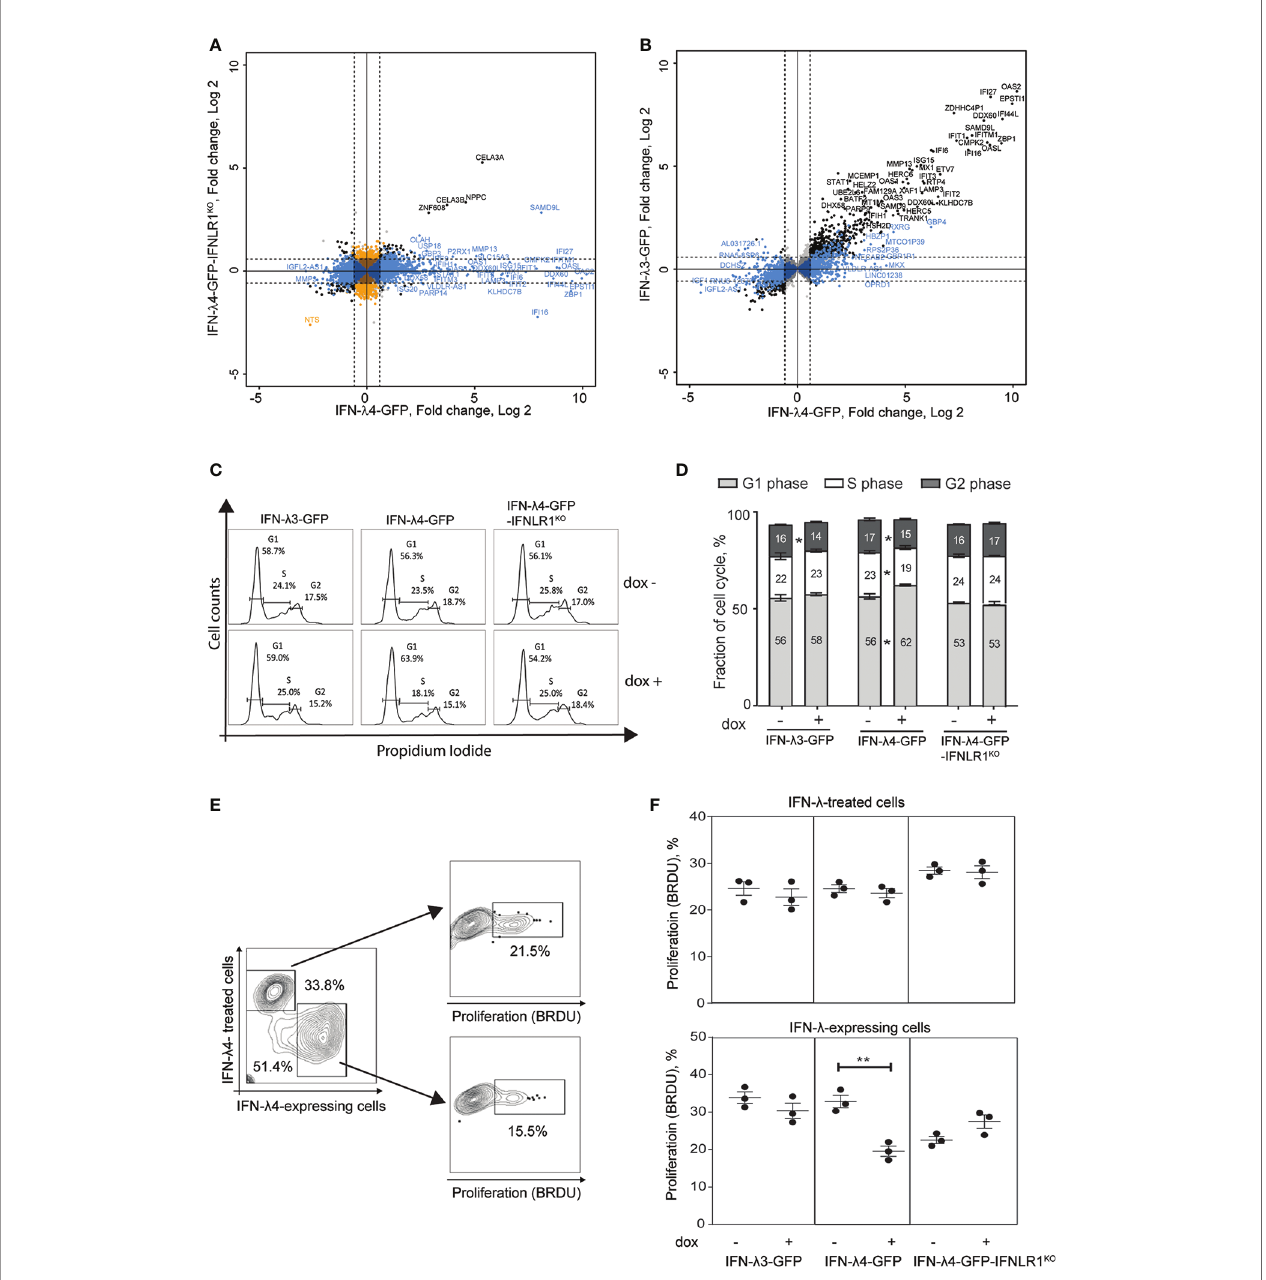
FIGURE 1 | IFN- l 4 inhibits the proliferation of HepG2 cells. RNA-sequencing analysis was used to identify differentially expressed genes (DEGs, P-FDR < 0.05) in IFN- l 3-GFP, IFN- l 4-GFP and IFN- l 4-GFP-IFNLR1 KO HepG2 cells after 72 hrs of induction by dox, compared to controls (dox- conditions). The cutoff threshold (fold change > +/-1.5) is indicated by dotted lines. (A) Analysis of all DEGs (n = 3251) detected for IFN- l 4-GFP or IFN- l 4-GFP-IFNLR1 KO cells. In blue - DEGs (n = 2,735) speci fi c to IFN- l 4-GFP and considered IFNLR1-dependent. In black - DEGs (n = 145) shared between both groups and considered IFNLR1-independent. In orange - DEGs (n = 371) speci fi c to IFN- l 4-GFP-IFNLR1 KO . (B) DEGs of IFN- l 4-GFP analyzed in IFN- l 3-GFP transcriptome. In black - DEGs (n = 1,506) shared in IFN- l 4- GFP and IFN- l 3-GFP and in blue - IFN- l 4-signature DEGs (n = 1,229) detected in IFN- l 4-GFP but not in IFN- l 3-GFP producing cells. Additional details are provided in Figure S2 and Table S1 . (C, D) Cell cycle analysis of cells synchronized by 24 hrs of serum starvation, treated with or without dox (0.5 µg/ml) for 72 hrs, and analyzed by fl ow cytometry after PI staining. The plot shows a representative picture and the percentage of cells in each phase of the cell cycle. All data are shown as mean± SEM from triplicate experiments. *P < 0.05, Student ’ s T-test comparing no dox to dox+ for each cell cycle stage. (E, F) Bromodeoxyuridine (BrdU, %) incorporation indicating cell proliferation in HepG2 cells expressing IFN- l 3-GFP, IFN- l 4-GFP and IFN- l 4-GFP-IFNLR1KO. Cells were cocultured with HepG2 cells labeled with Far Red proliferation dye, dox-induced for 72 hrs, and treated with BrdU for 3 hrs before analysis. Gates show HepG2 cells exposed to IFN- l s (IFN- l treated cells) and HepG2 expressing IFN- l s. P-values compare corresponding dox+ vs. dox- HepG2 cells, **p < 0.01, Student ’ s T-test. Graphs represent one of three independent experiments, each in biological